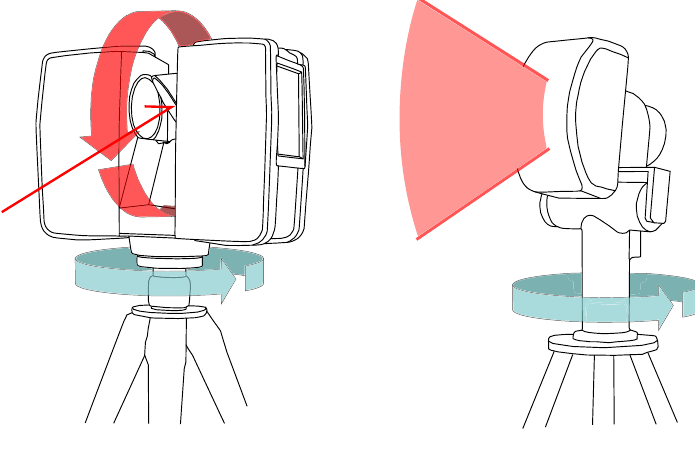
Figure 4. Schematic representation of acquisition sensors: The Faro (cid:114) (Lake Mary, FL, USA) Focus 3D (cid:114) X330 TLS ( Left ); The Blueview (Bothell, WA, USA) BV5000 mechanical scanning sonar (MSS) ( Right